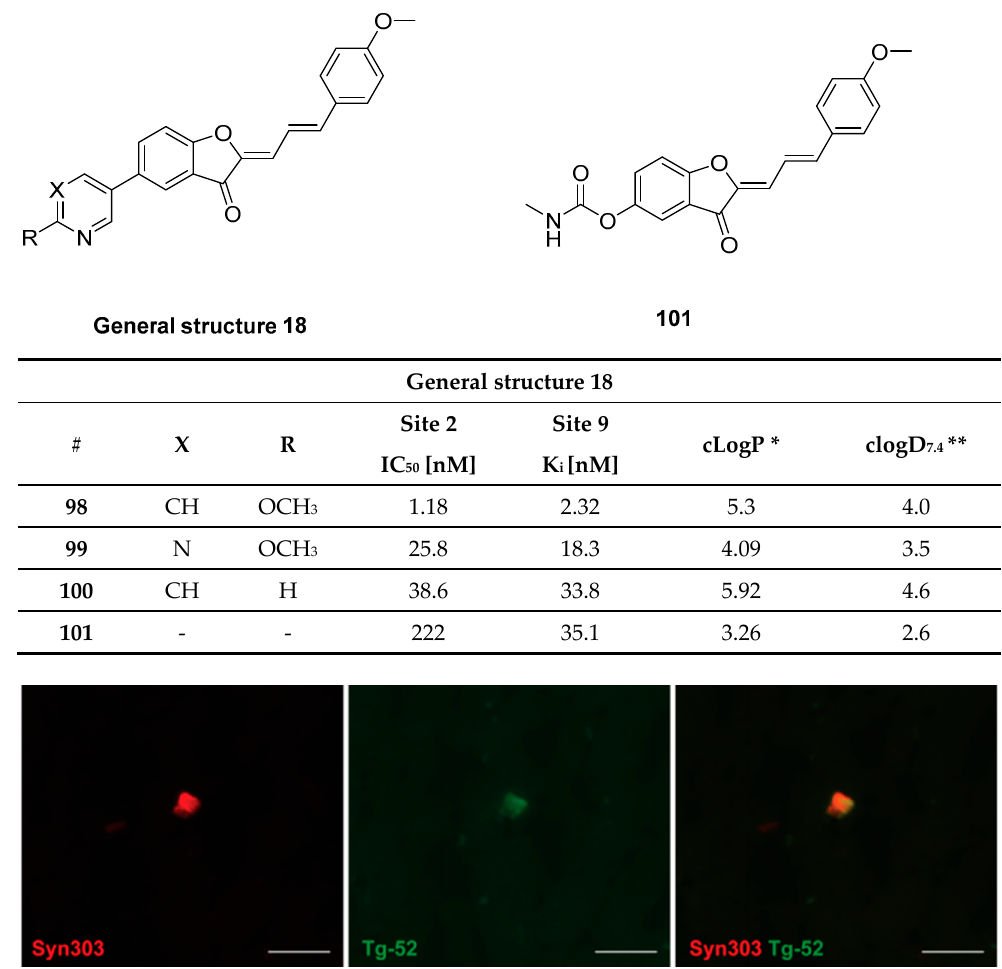
Figure 32. Chemical structure of 99-101 with binding IC 50 and K i values. Fluorescence microscopy studies of 98 in postmortem PD tissue. Image shows LB immunostained with syn303 antibody and 98 .Reprinted with permission from [149]. Copyright 2020 The Royal Society of Chemistry. * clogP values were calculated by BioByte. ** clogD 7.4 values calculated by ACD/Percepta.